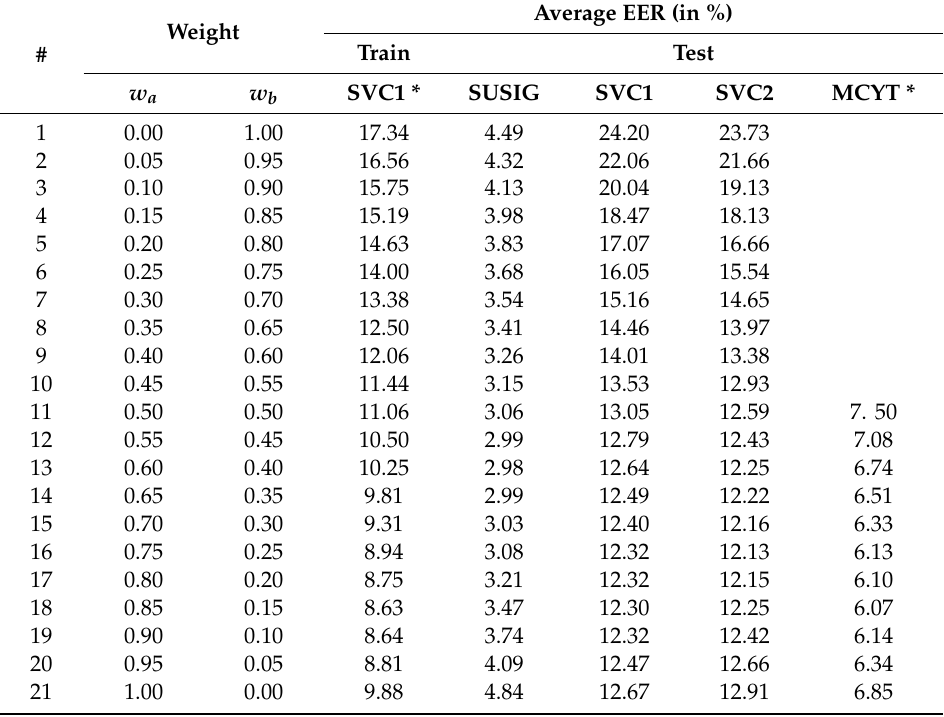
Table 4. EERs under di ff erent weights on four